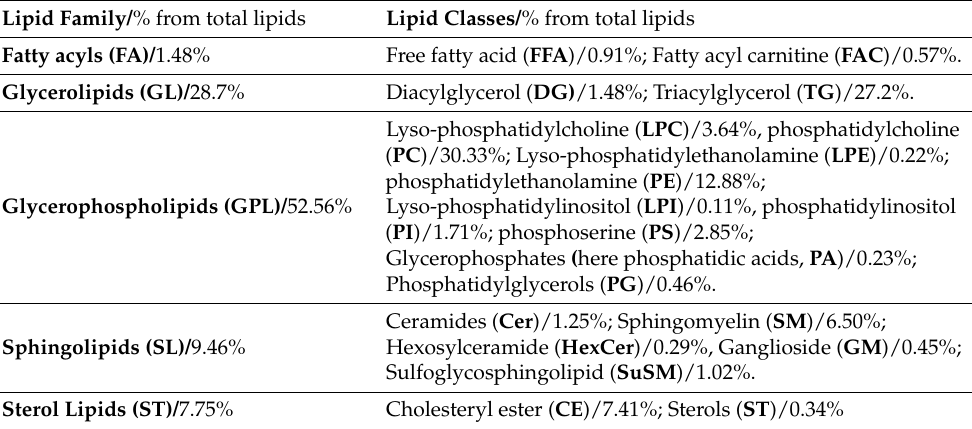
Table 1. Classification and distribution of lipids detected in bovine ovarian follicle. Lipid Family/ % from total lipids Lipid Classes/ % from total